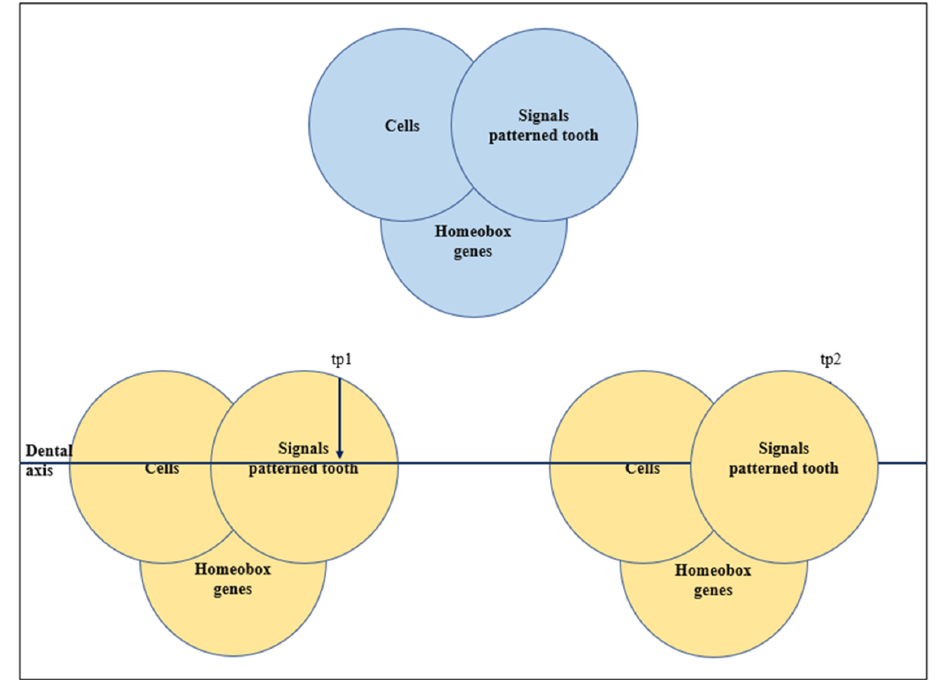
Figure 8. Co ‐ operative genetic interaction (CGI) model (derived from Mitsiadis & Smith (2006) [46]) tp1 refers to tooth position 1, tp2 refers to tooth position 2.